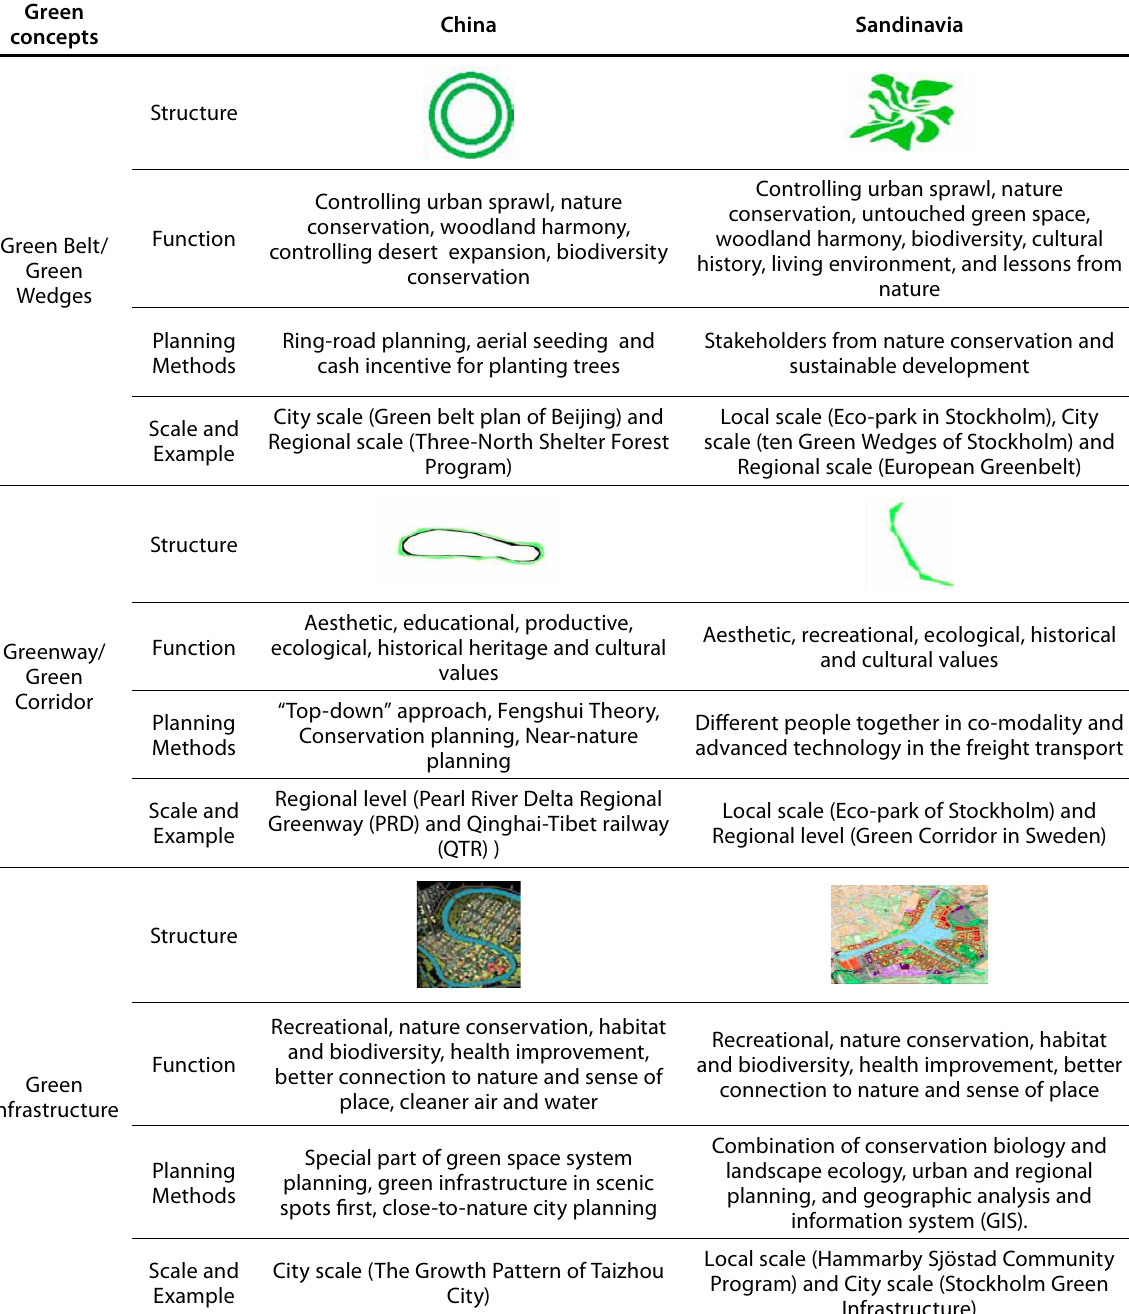
Green Belt/ Green Wedges